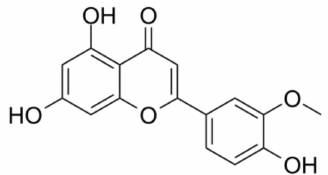
Figure 3. The chemical structure of